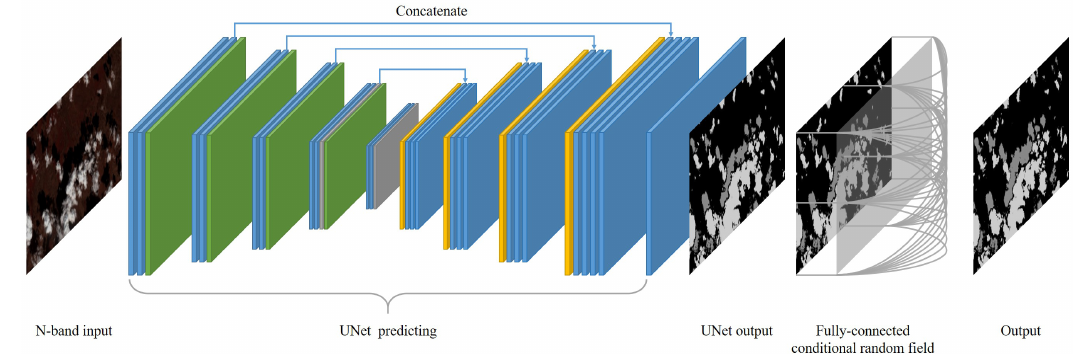
Figure 2. The entire pipeline of Refined UNet. UNet is first employed to localize clouds and shadows roughly, and Dense CRF refines the boundaries of clouds and shadows by taking the UNet prediction as the unary potential.